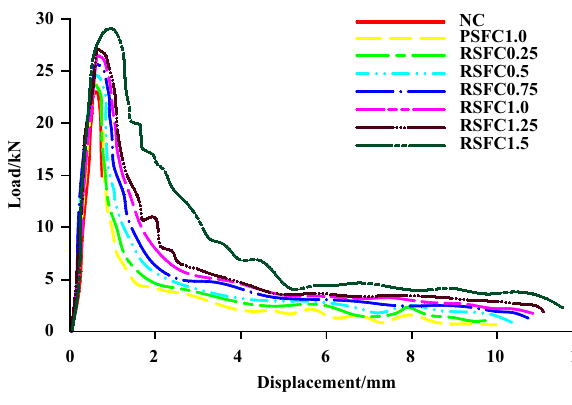
Figure 18: Concrete toughness curve.